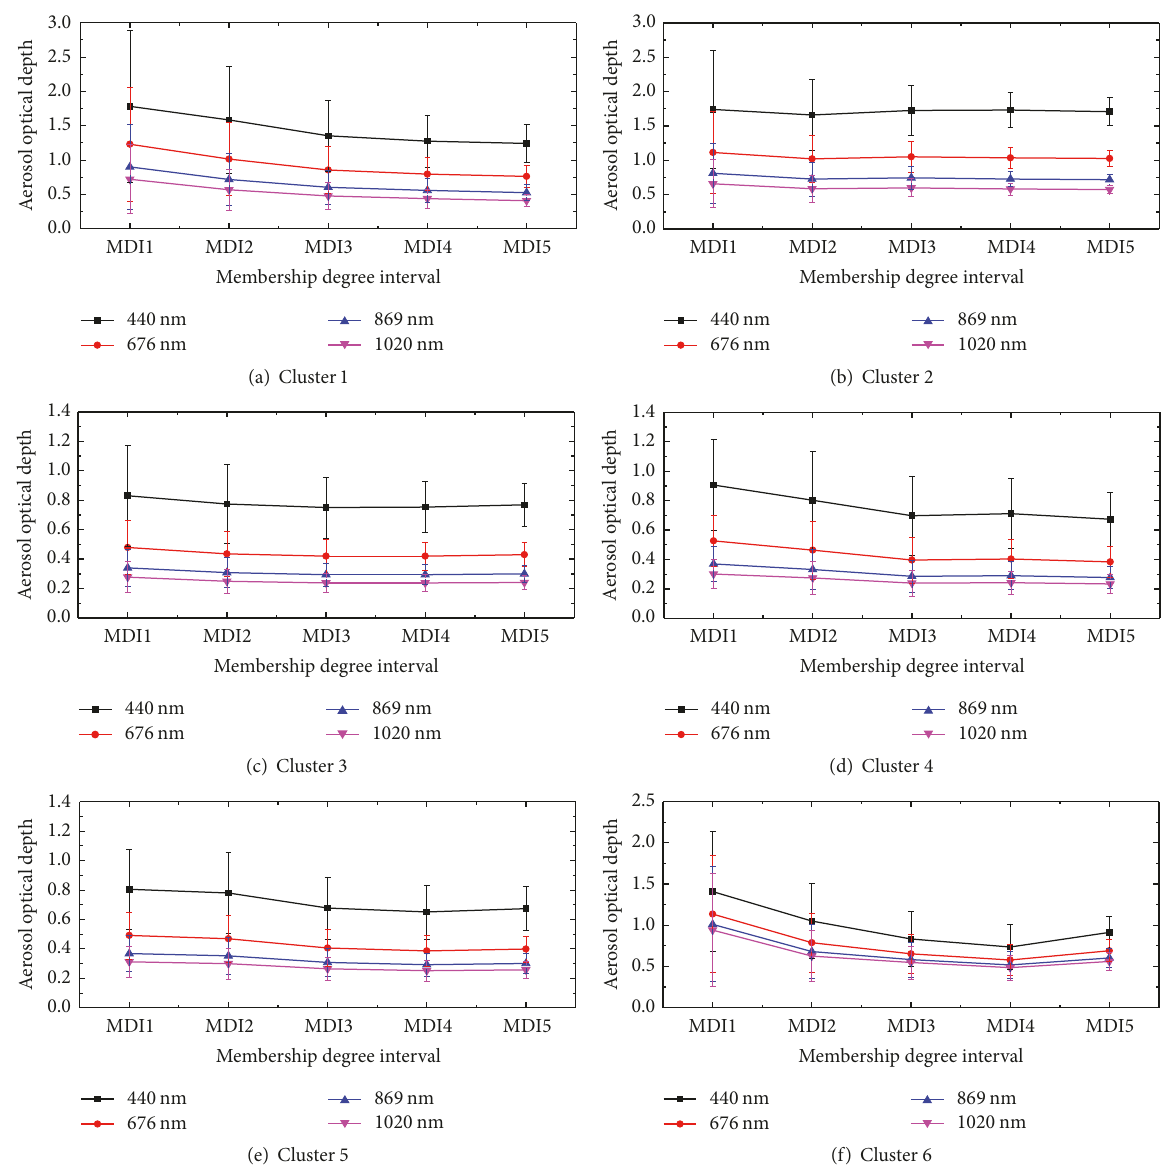
Figure 10: Variation of AODs with membership degree intervals at four wavelengths: the vertical bars represent the standard